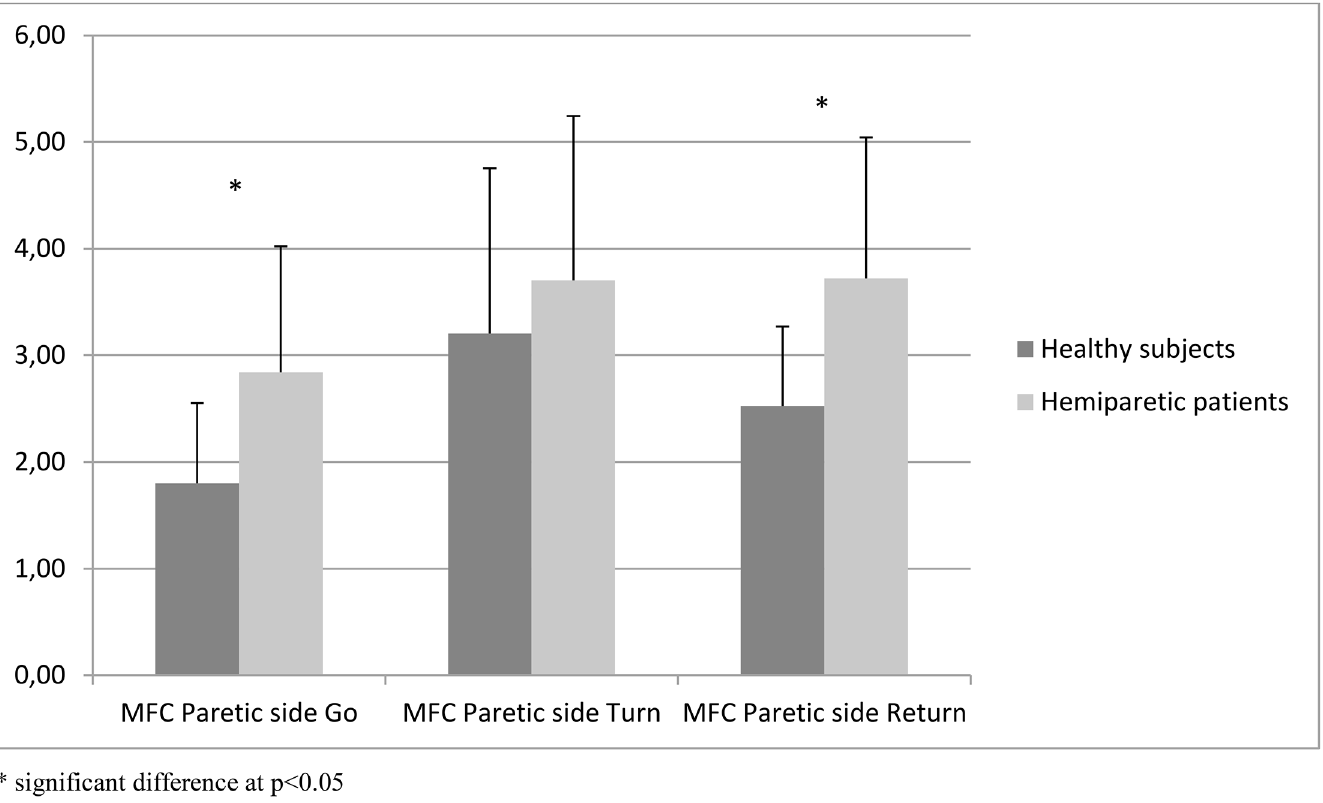
Fig 2. Minimum foot clearance on paretic side.